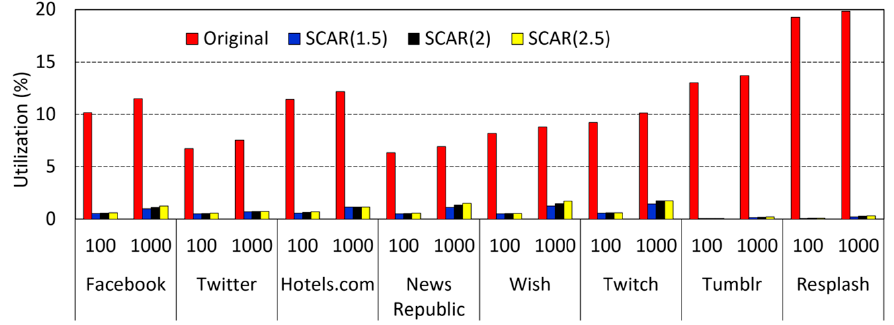
Figure 9. Average GPU utilization.